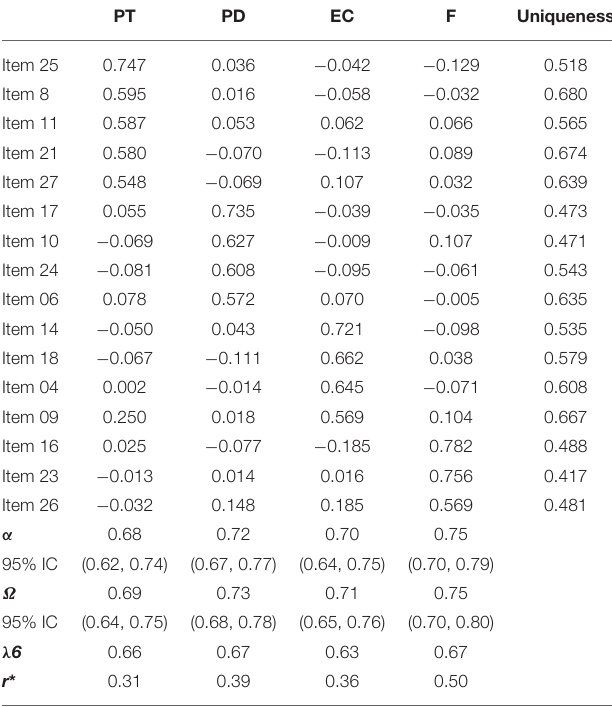
TABLE 2 | Pattern Matrix EFA (16 items).